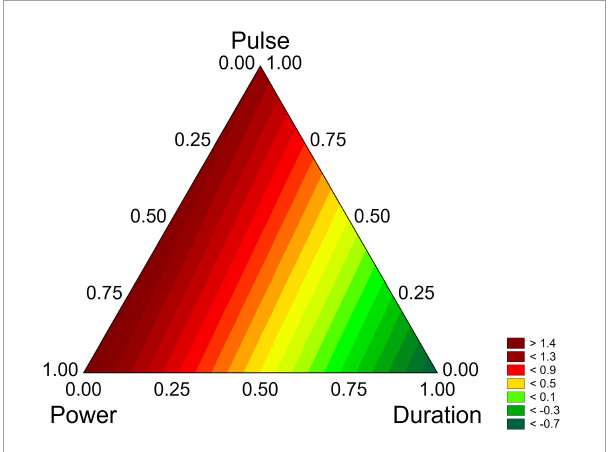
FIGURE8 Triangular plots for the effect the factors of US-treatment (power, duration, and pulse) on biofilm stability compared to